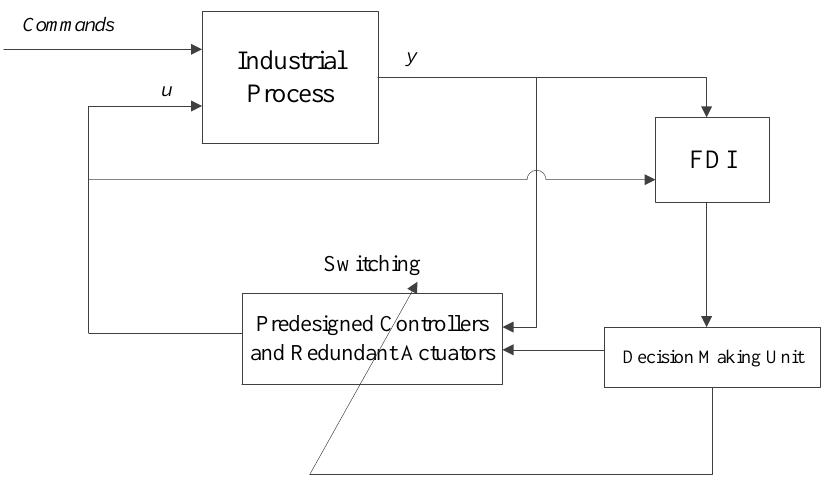
Figure 5. The general structure of the Switching-based active FTC system.